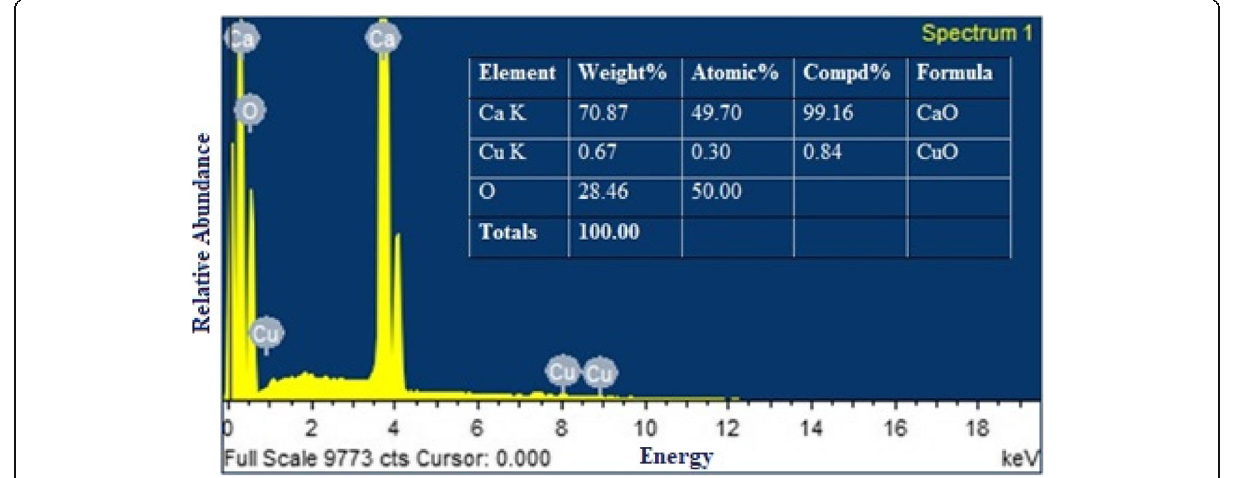
terification of esterified mixture further diminishes